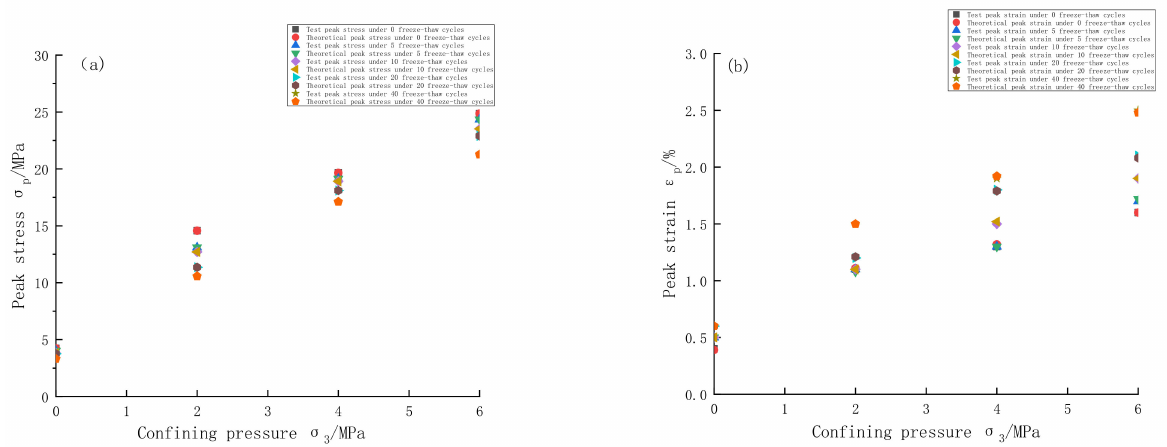
Figure 1. ( a ) Peak stress of different confining pressures under the same number of freeze-thaw cycles. ( b ) Peak strain of different confining pressures under the same number of freeze-thaw